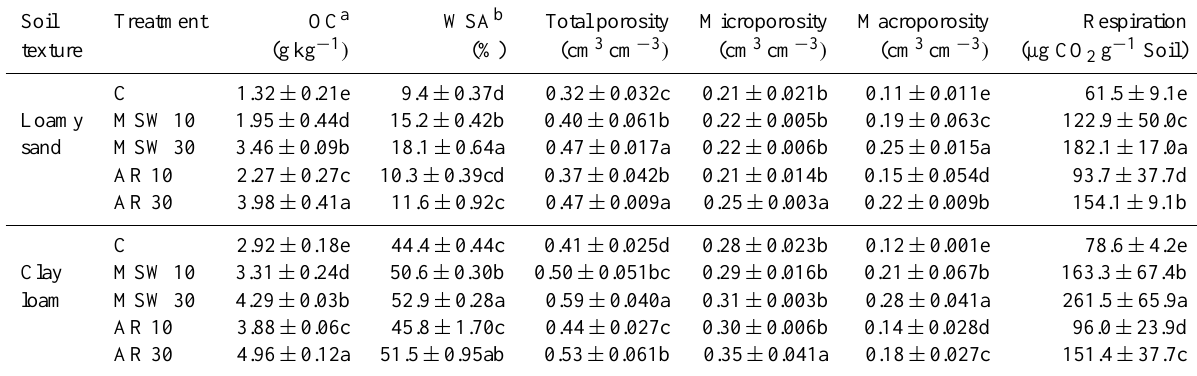
Table 3. Mean ± standard deviation values of the selected soil properties for each soil texture treated with different rates of organic amend- ments ( n =